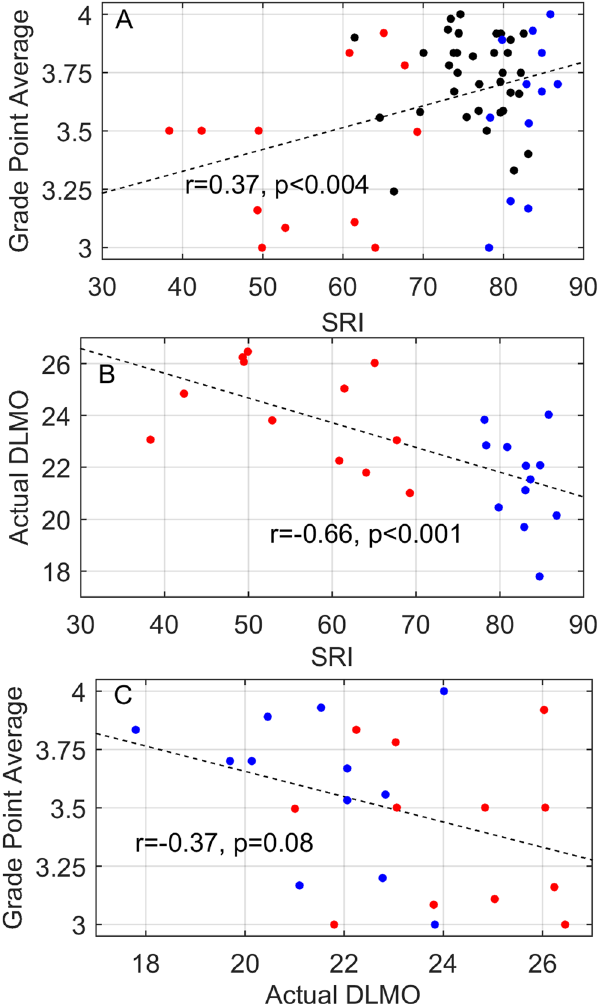
Figure 5. Correlations between sleep regularity index (SRI), grade point average (GPA), and timing of melatonin secretion. Panels (A, B and C) show the relationships between the variables: SRI, GPA, and salivary DLMO. Dashed lines show the linear fits, with r-values and p-values shown for each linear (Pearson) correlation. Each data point represents an individual, with colors indicating whether the individual was a member of the Regular (blue), Irregular (red), or neither group (black). Note that DLMO was only assessed in the Irregular and Regular